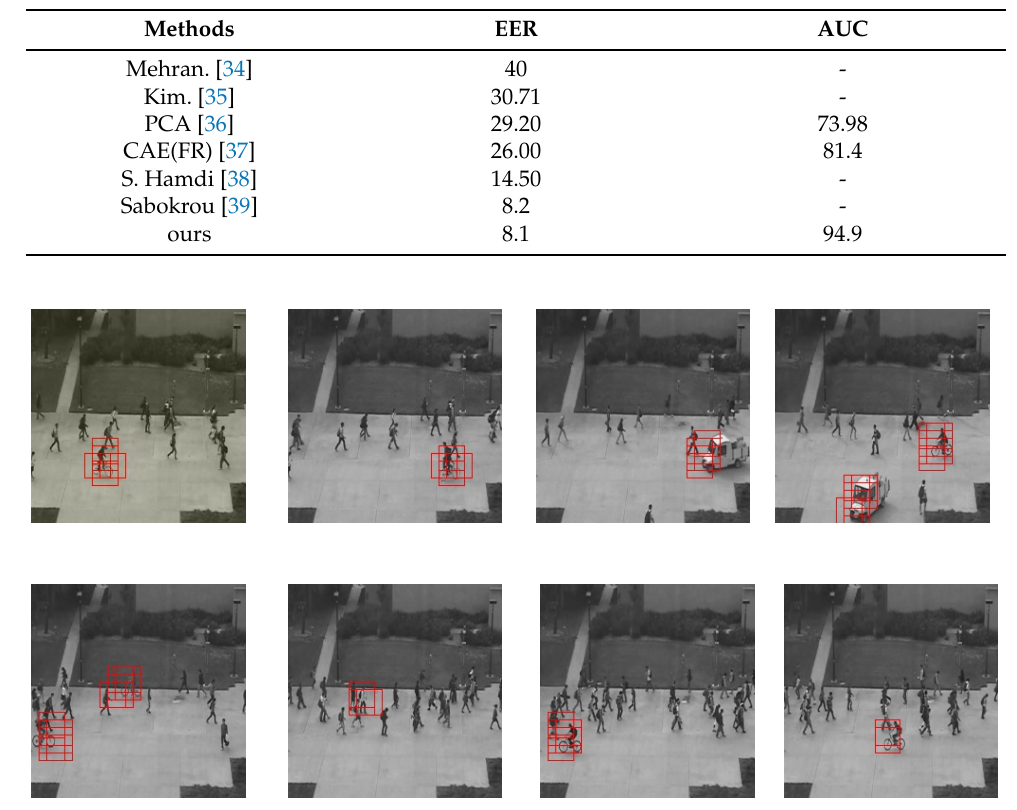
Figure 9. Ourresults on the Ped2 dataset.